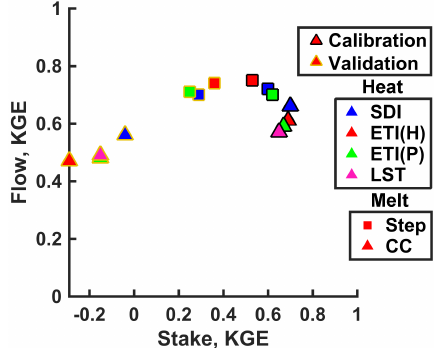
Figure 5. Model performance for Gulkana using Gulkana calibra- tion (i.e., parameters from Table B1) and validating each model for Gulkana from September 1990 through August 2000. Only stake and flow observations are available during this validation period. The marker border indicates the whether the model period is cali- bration or validation, face color indicates heat module representa- tion, and shape indicates mass flux module representation, as de- scribed in the